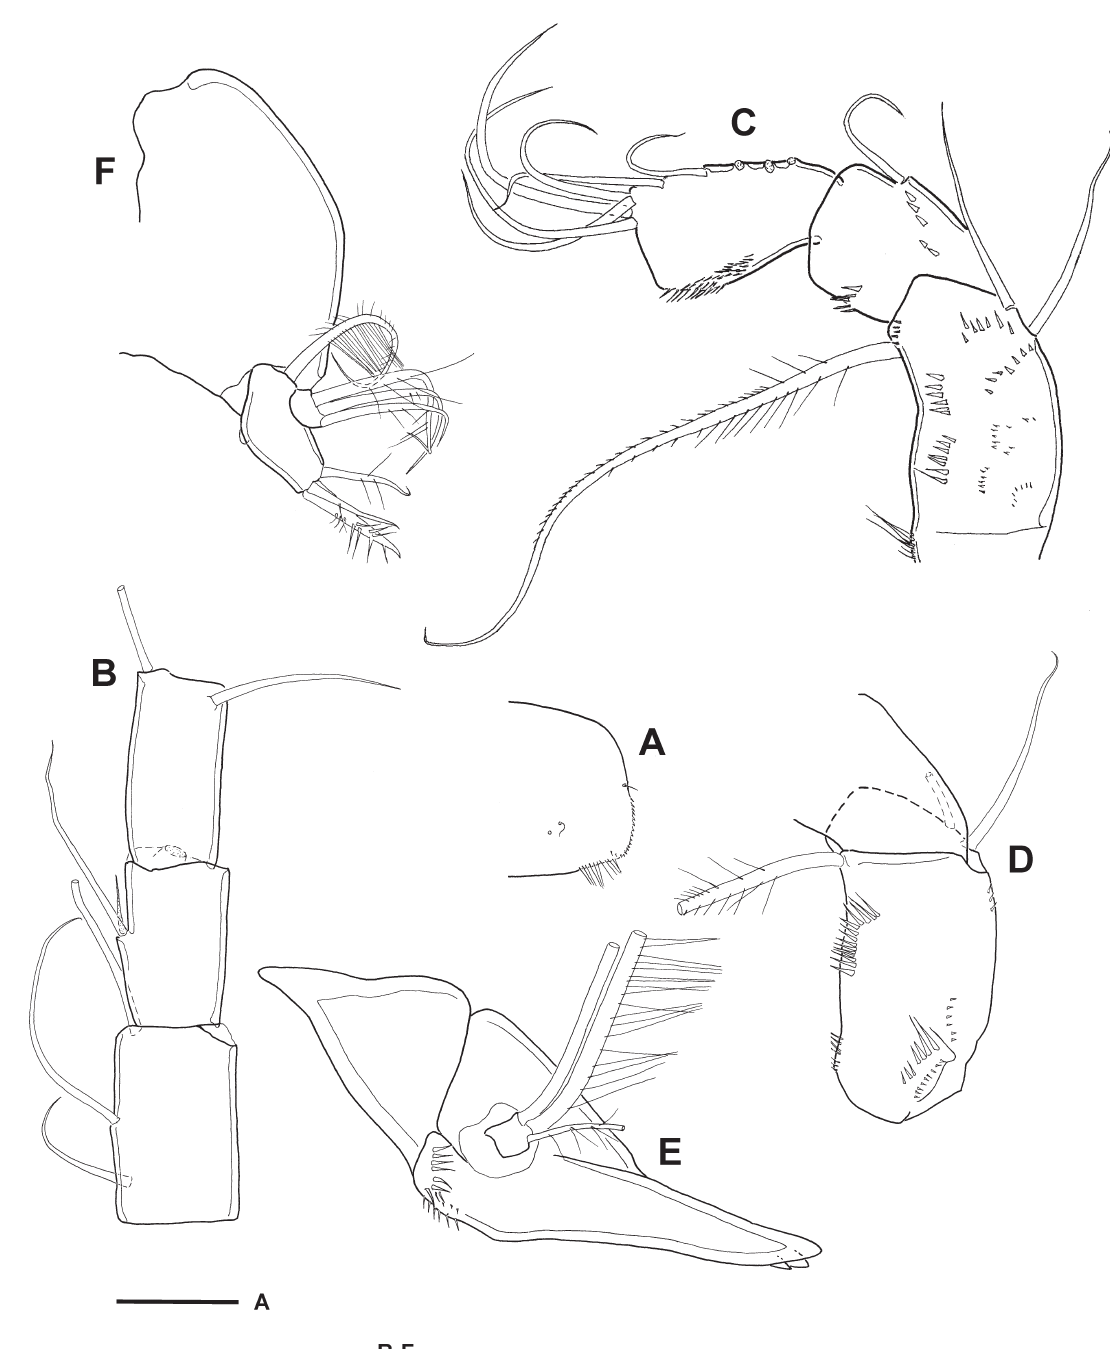
Fig. 2. Eucyclops azorensis Defaye & Dussart, 1991, ♀ (Azores, paratypes; MNHN Cp. 611). A . Pediger 4, lateral section, dorsal view. B . Antennulary segments 8−10, dorsal surface − note short aesthetasc on segment 9. C . Antennal coxobasis and first and second endopodal segments, caudal view – note the suture line between basipodite and coxopodite. D . Antennal coxobasis, frontal view. E . Mandible. F . Maxillule. A, C−F show ♀-1; B shows ♀-2. Scale bars: A−F = 50